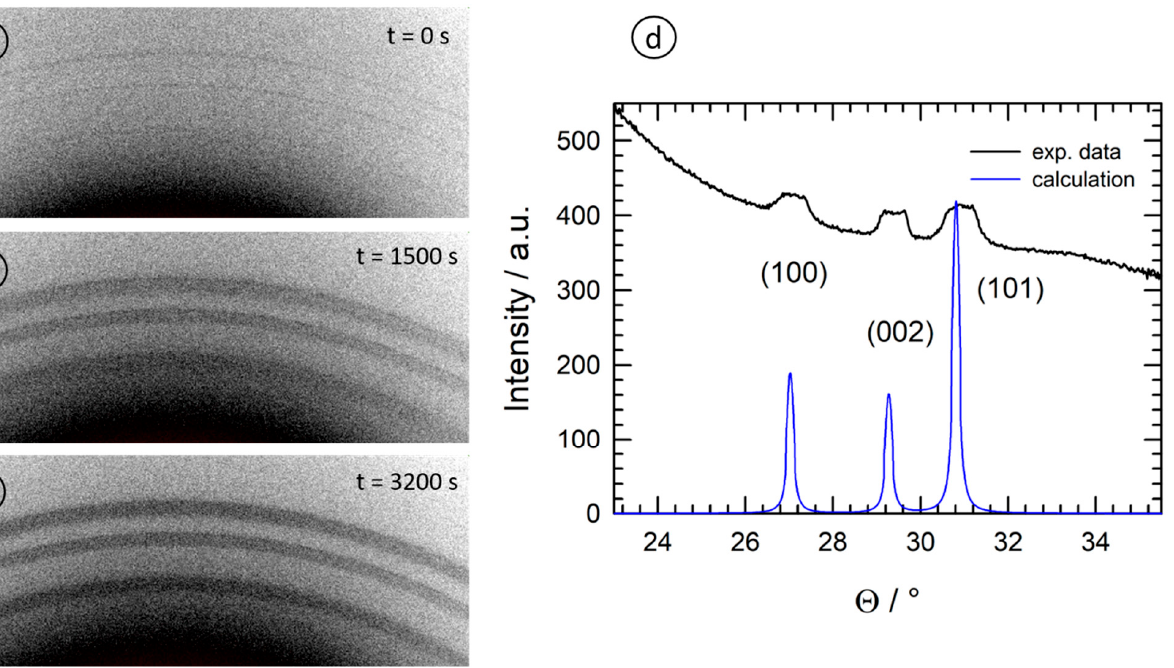
Figure 7. Selected diffraction patterns collected during the solvothermal reaction of Zn(acac) 2 in 1-octanol (sample O) for a photon energy of 9.423 keV; ( a ) t = 0 s; ( b ) t = 1500 s; ( c ) t = 3200 s. In ( d ), the diffractogram calculated by azimuthal integration is compared to a theoretical calculation for ZnO having Wurtzite structure without any preferential orientation (space group P 63 mc, a = b = 3.251 Å, c = 5.207 Å; α = β = 90°, γ = 120°, [38]).